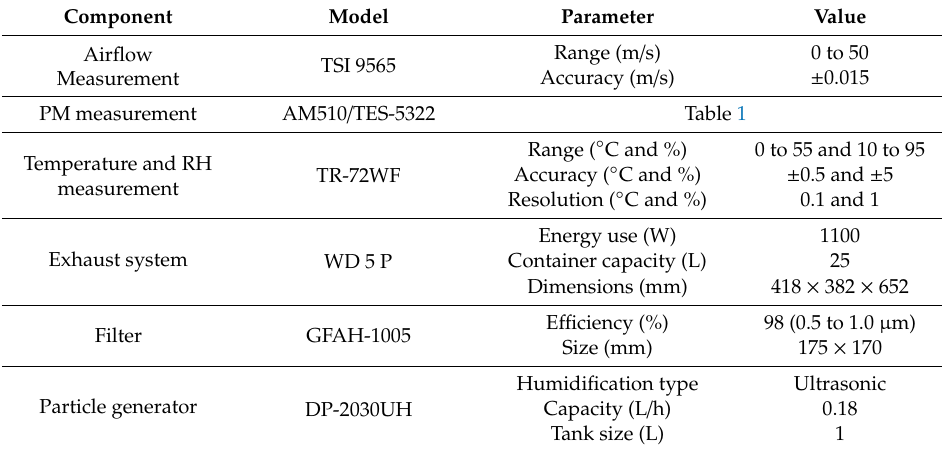
Figure 3. Schematic diagram of the calibration system using a small chamber. Table 4. Specifications of the experimental apparatus for equipment